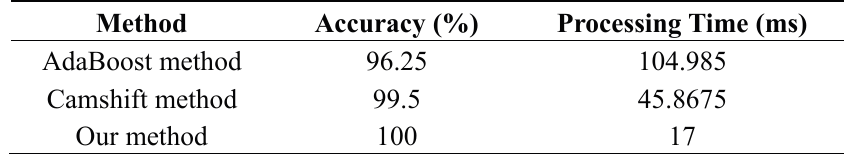
Table 6. Comparisons of the accuracies and processing time of eye ROI detection by AdaBoost, Camshift, and our